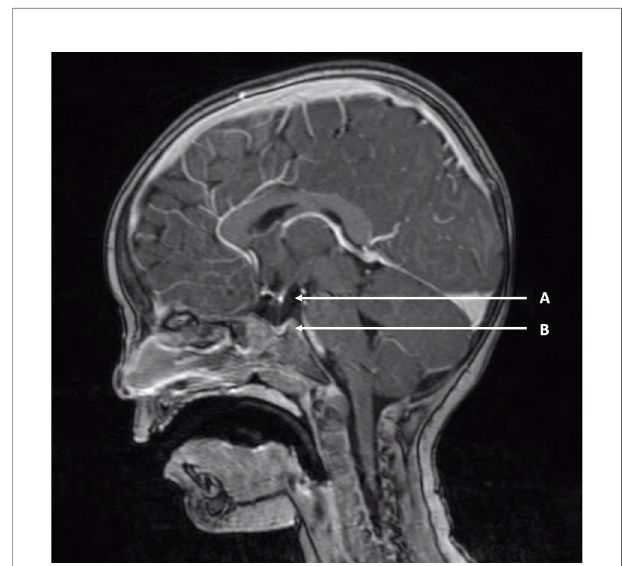
FIGURE 3 | Example of pituitary stalk interruption syndrome. T1-weighted MRI of a two-year-old boy with pituitary stalk interruption syndrome. (A) “ Bright white spot ” of ectopic posterior pituitary positioned at the hypothalamic base. (B) Hypoplastic anterior pituitary in the sella turcica. A thin pituitary stalk is visible between (A, B)